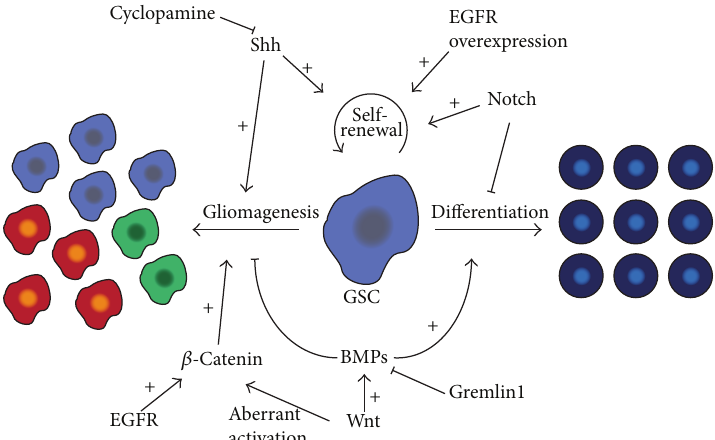
Figure 1: Summary of key molecular pathways regulating steps in glioma stem cell self-renewal, differentiation, and